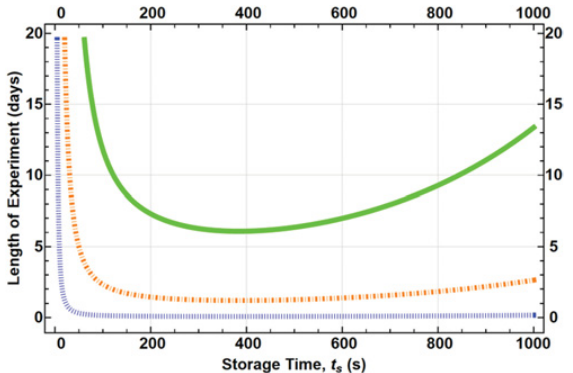
Figure 8. Plot showing the length of the predicted run time it (cid:1) (cid:2) = 0 takes to achieve a sensitivity in τ B (at 95% C.L.) w.r.t. storage nn (cid:1) time. Here, the blue dotted curve indicates a goal of τ nn (cid:1) ≥ 12s, the orange dot-dashed curve corresponds to a goal of τ nn (cid:1) ≥ 24s, and the green curve shows the time required to achieve a goal of τ ≥ 36s. nn (cid:1)